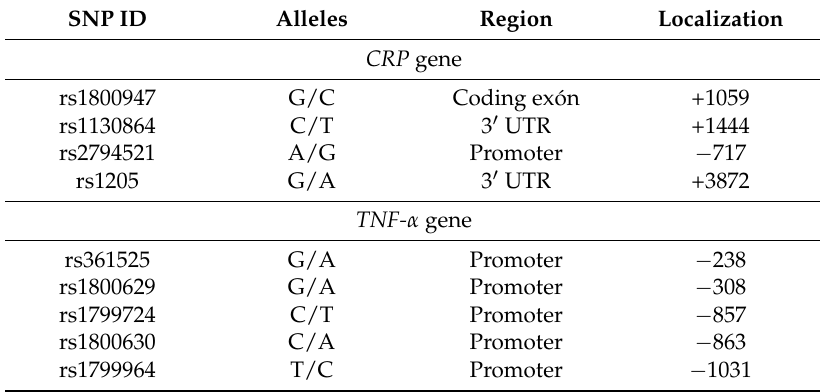
Table 1. Single nucleotide polymorphisms (SNPs) of the C-reactive protein (CRP) and tumor necrosis factor-alpha (TNF- α ) genes in this protocol